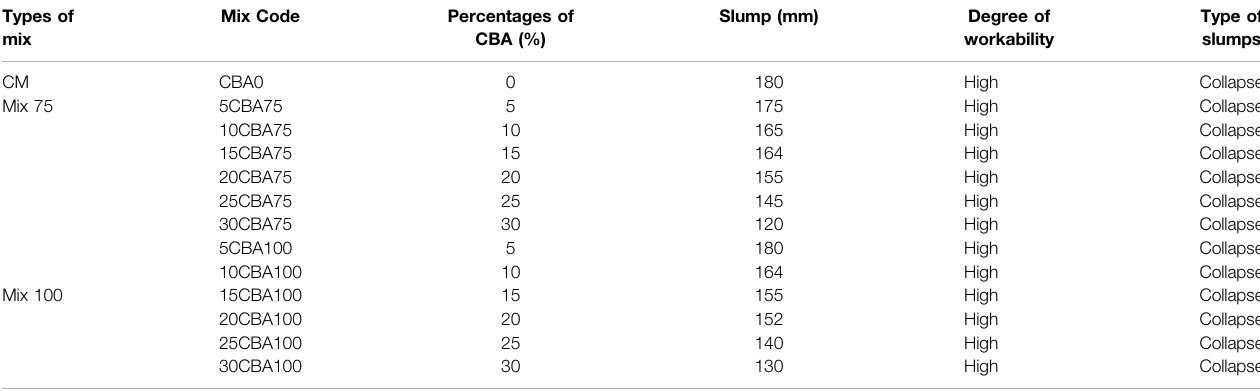
TABLE 6 | Percentages of CBA (%), slump (mm), and types of slumps.